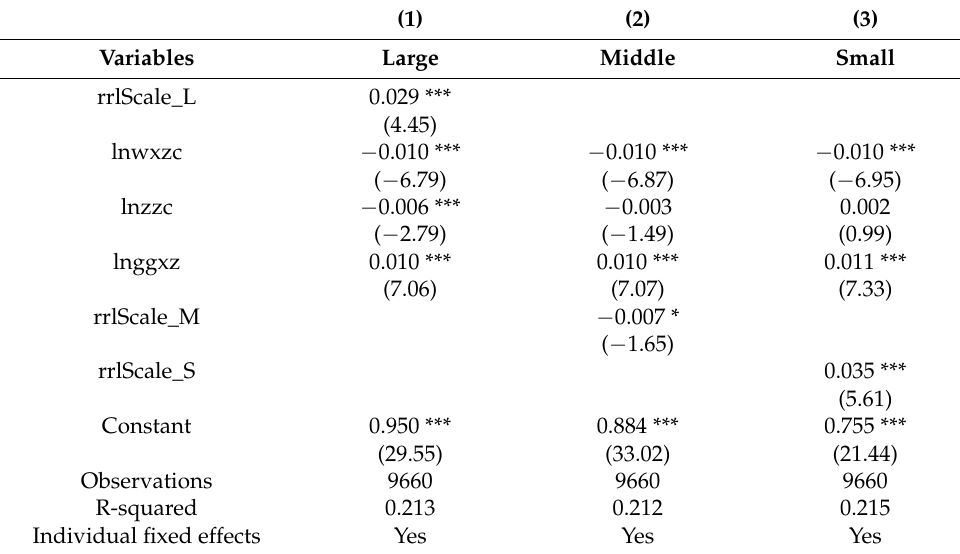
Table 7. Heterogeneity analysis on enterprise scale based on